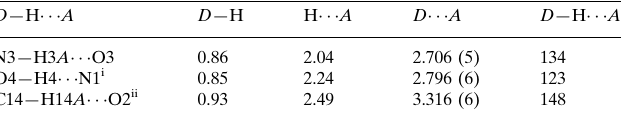
Hydrogen-bond geometry (A˚ , (cid:2)